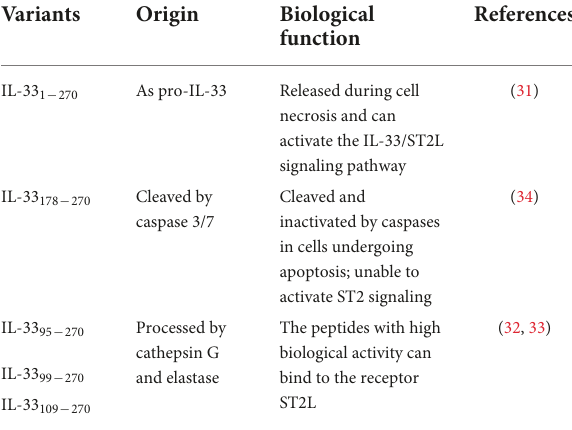
TABLE 1 The origins and biological functions of